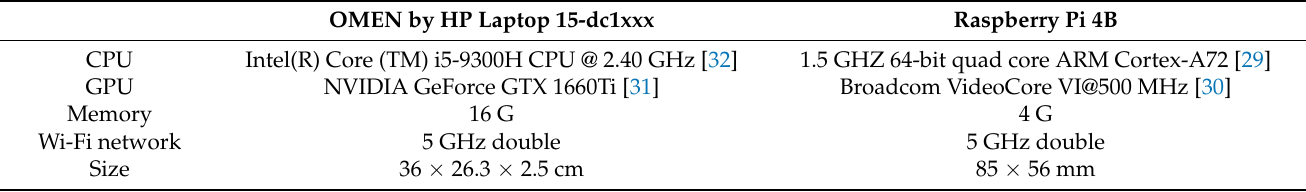
Table 2. Detailed specifications of local computer and Raspberry Pi 4B.